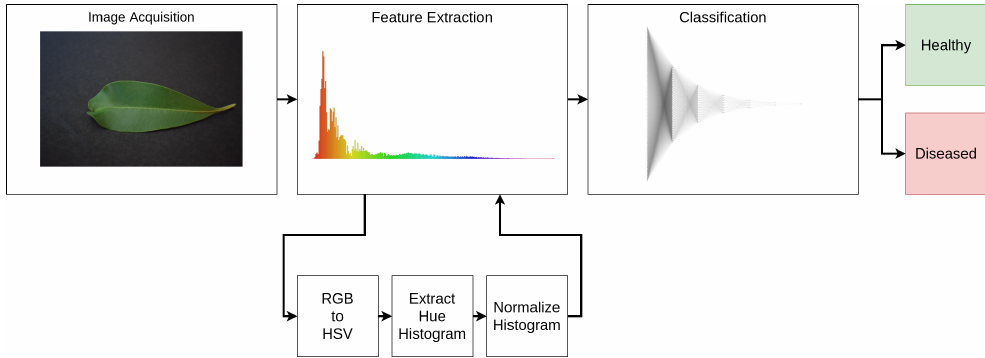
Figure 8. Data processing pipeline and associated substages. For the image extraction, the associated stages are the color space conversion and histogram extraction.